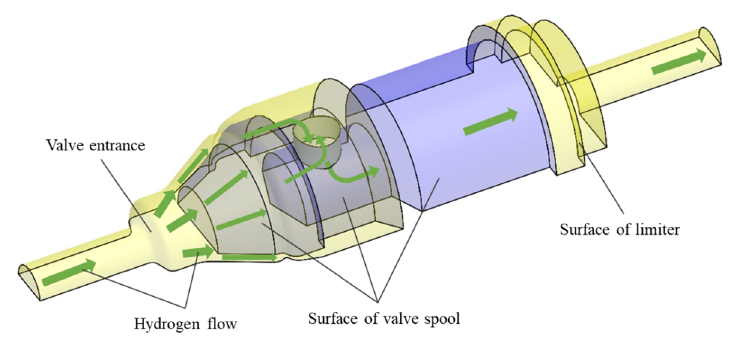
Figure 3. Flow-channel model of the check valve.